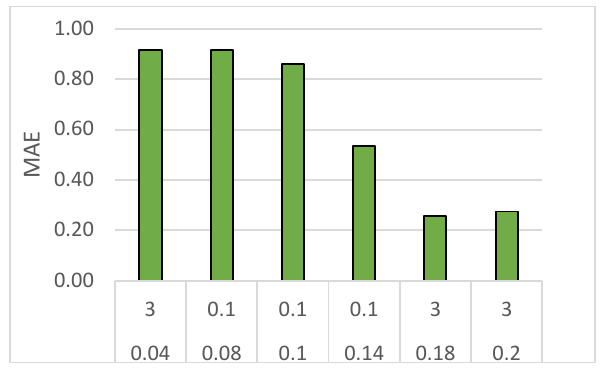
Figure 7. Performance comparison between PDCF, NRCF, and PCC under different